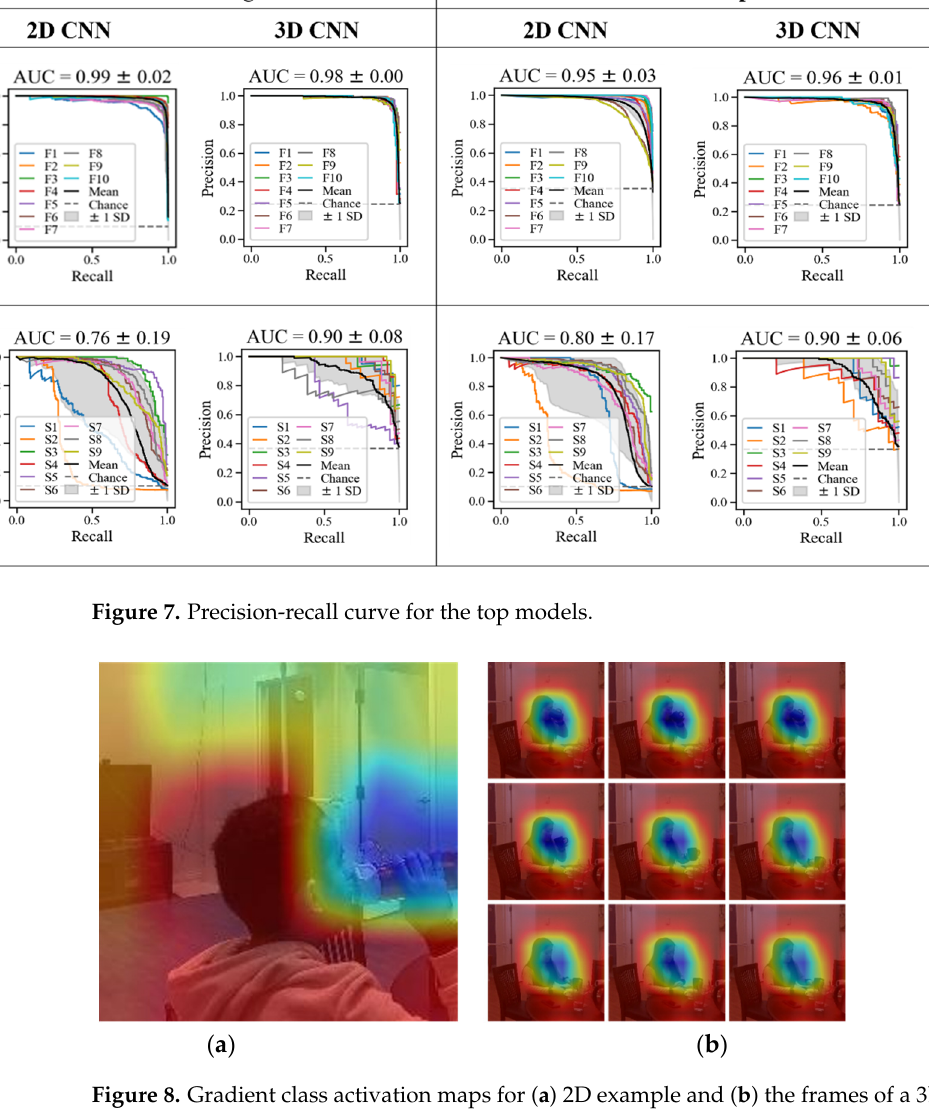
Figure 8. Gradient class activation maps for ( a ) 2D example and ( b ) the frames of a 3D example.